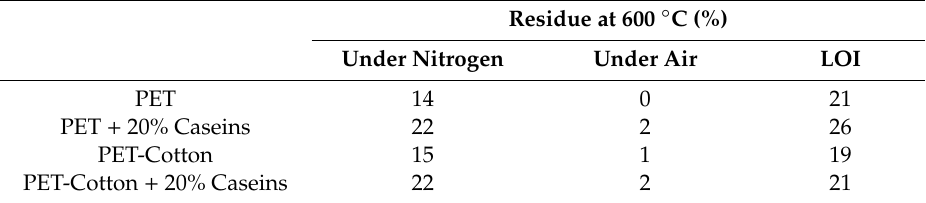
Figure 8. Casein-treated cotton residue SEM [36]. Figure 8. Casein ‐ treated cotton residue SEM [36]. Table 2. TGA and LOI data for PET–cotton bend treated with caseins Table 2. TGA and LOI data for PET–cotton bend treated with caseins [11].